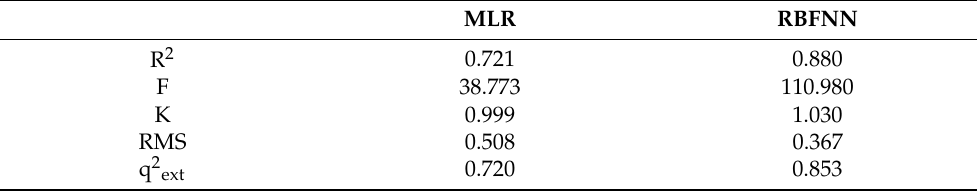
Table 4. The statistical results of the external test set for the MLR and RBFNNs models.